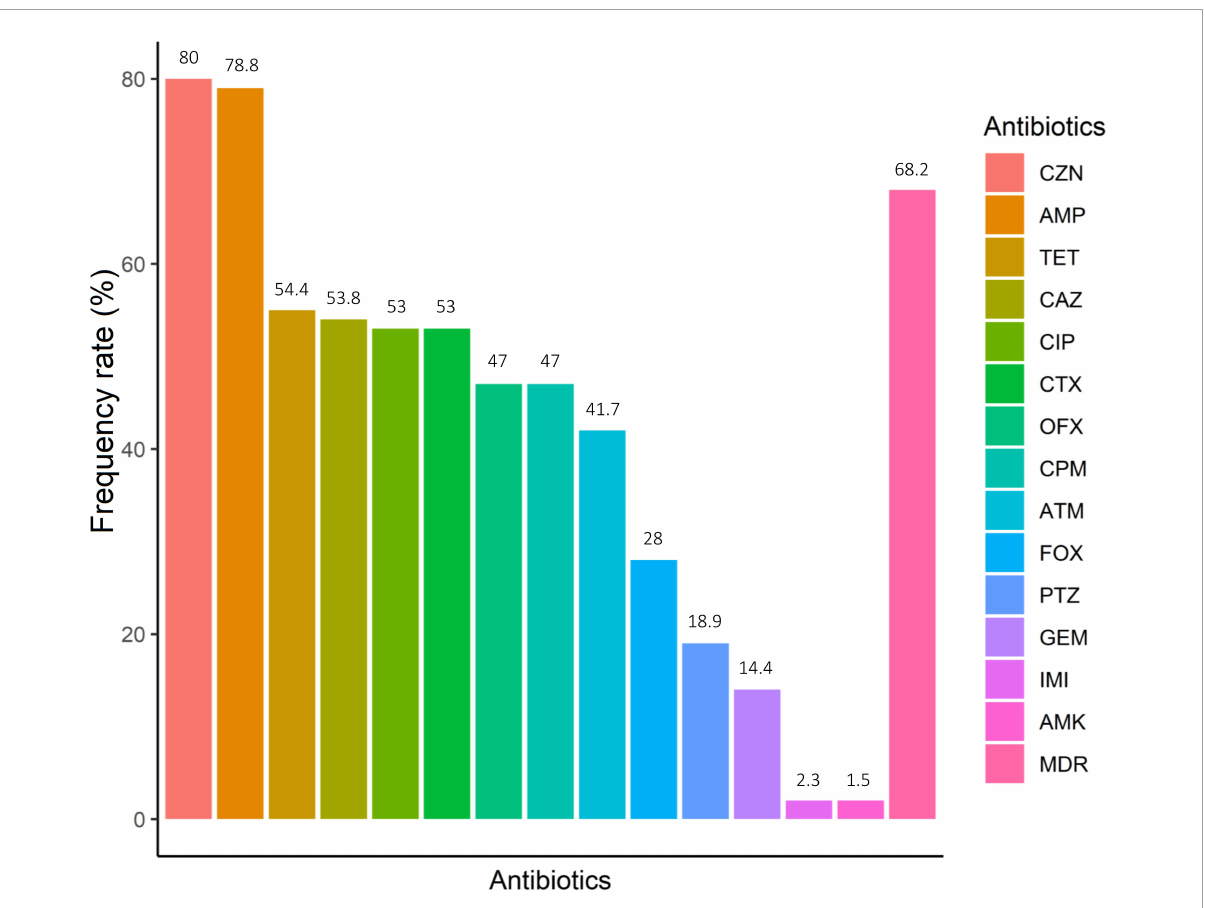
FIGURE1 Antimicrobial resistance of IBD-associated E. coli . Amikacin (AMK), ampicillin (AMP), cefotaxime (CTX), piperacillin/tazobactam (PTZ), cefazolin (CZN), cefoxitin (FOX), ceftazidime (CAZ), cefepime (CPM), imipenem (IMI), aztreonam (ATM), ciprofloxacin (CIP), ofloxacin (OFX), gentamicin (GEM) and tetracycline (TET). *MDR,